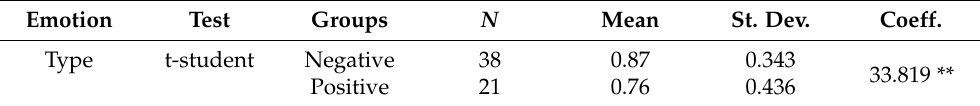
Table 5. Bivariate Analysis of